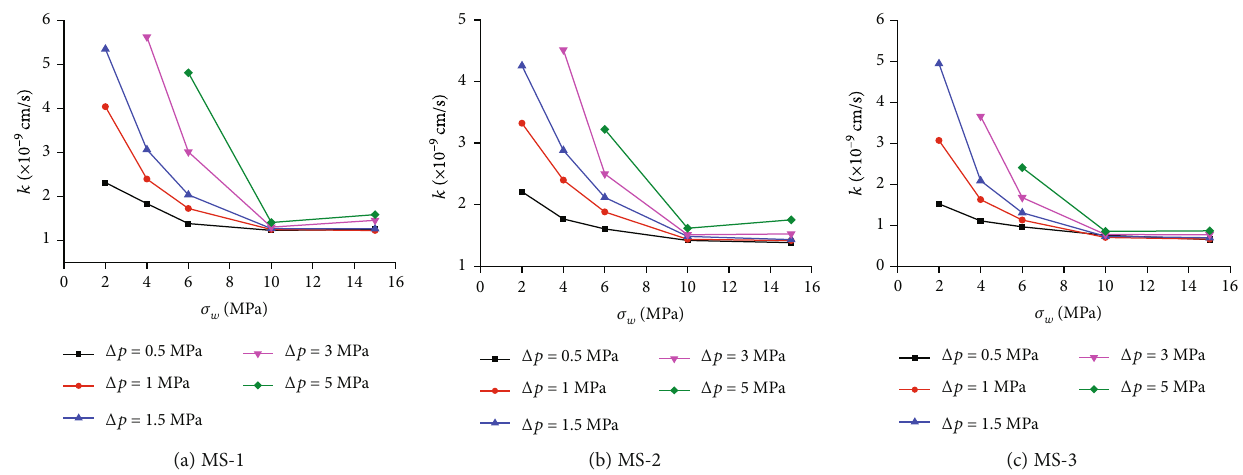
Figure 19: Relationship between permeability coe ffi cient and con fi ning pressure for